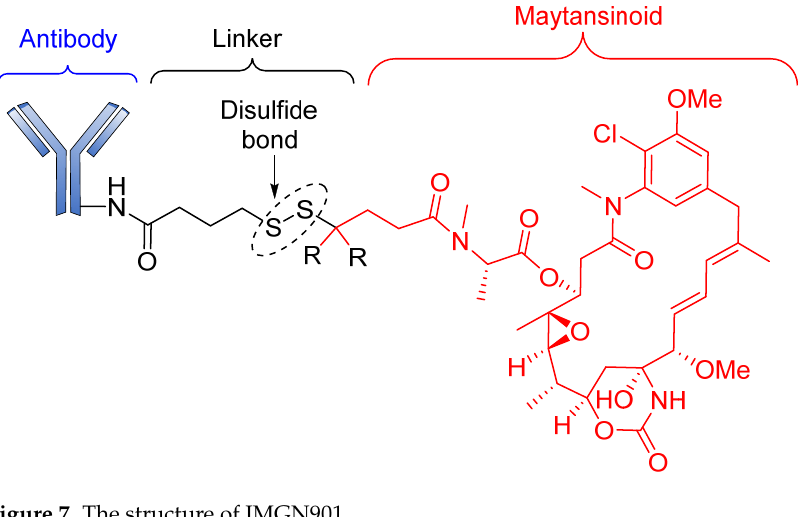
Figure 7. The structure of IMGN901.